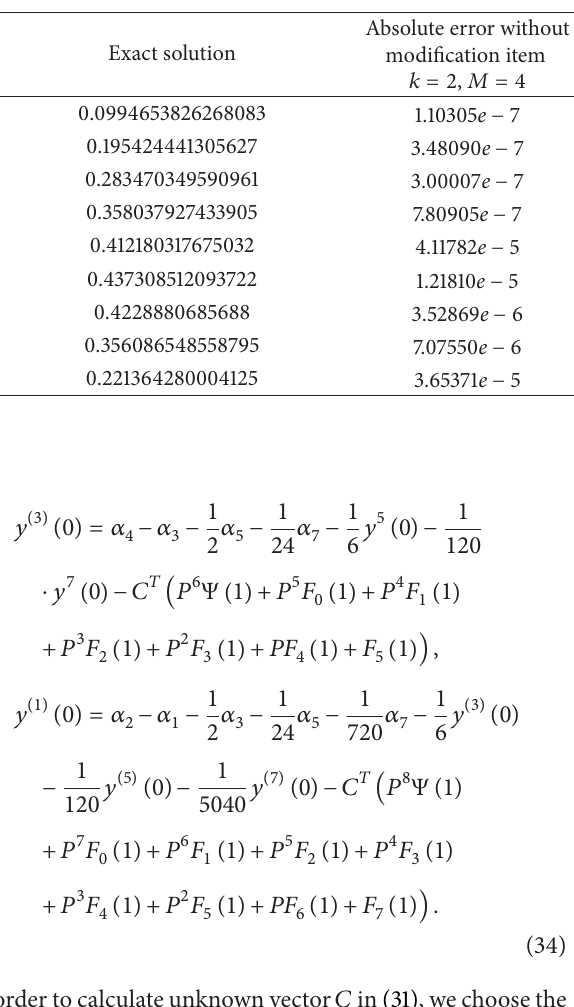
Table 1: Comparison of approximate solution and exact solution of 𝑘 = 2 and 𝑀 = 4 , 6 ,